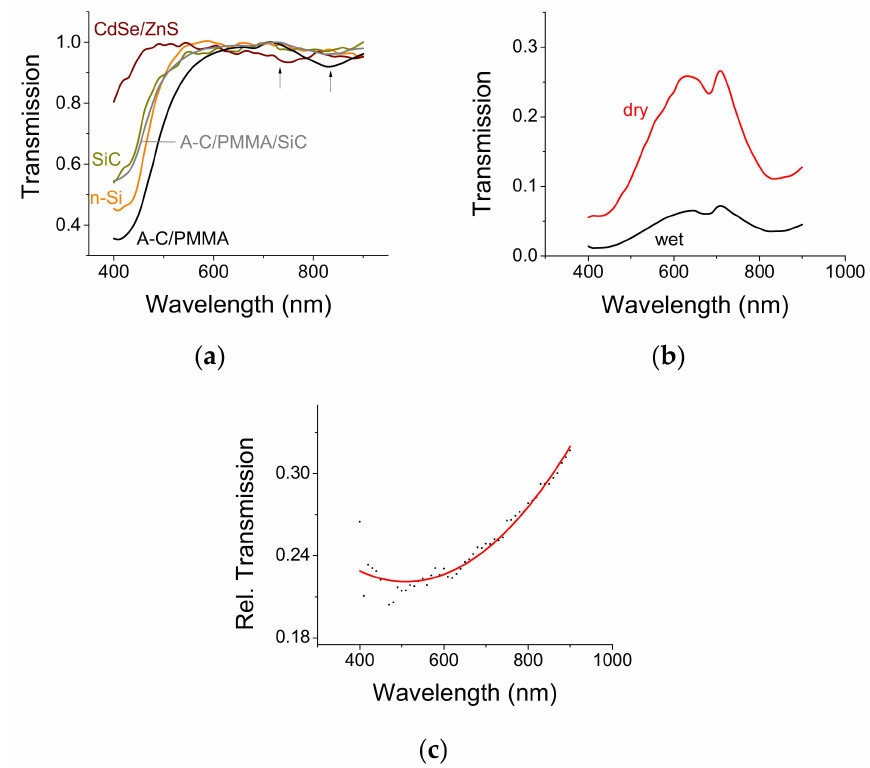
Figure 2. ( a ) Normalized optical transmission through the various film components used in the experiments. The peak transmission was set to 1 for each curve in order to accentuate the spectral response. ( b ) The absorption of A-C with a PMMA binder on a glass slide under dry and wet conditions. The curves are given as-is without peak normalization. ( c ) The relative transmission when the transmission under wet conditions was normalized by the transmission under dry